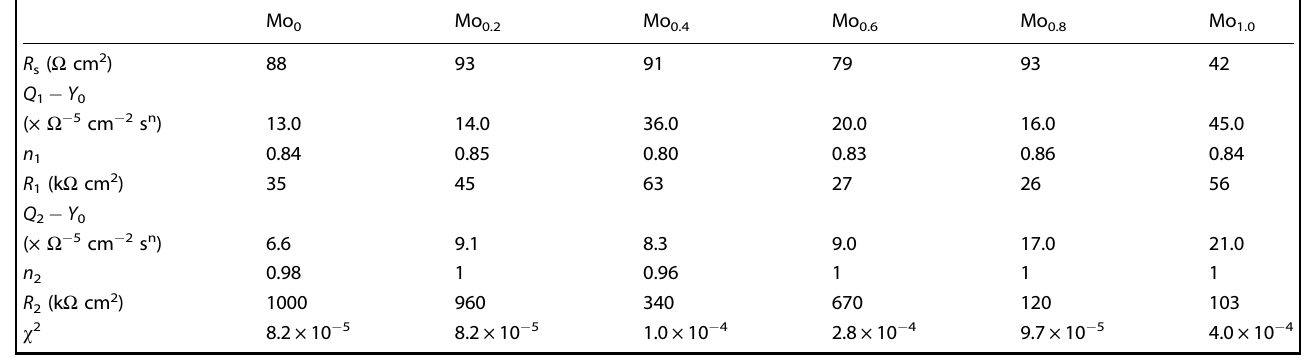
Table 3. The fi tted parameters for EIS of the as-cast CoCrFeNiMo x HEAs in 5 mM H 2 SO 4